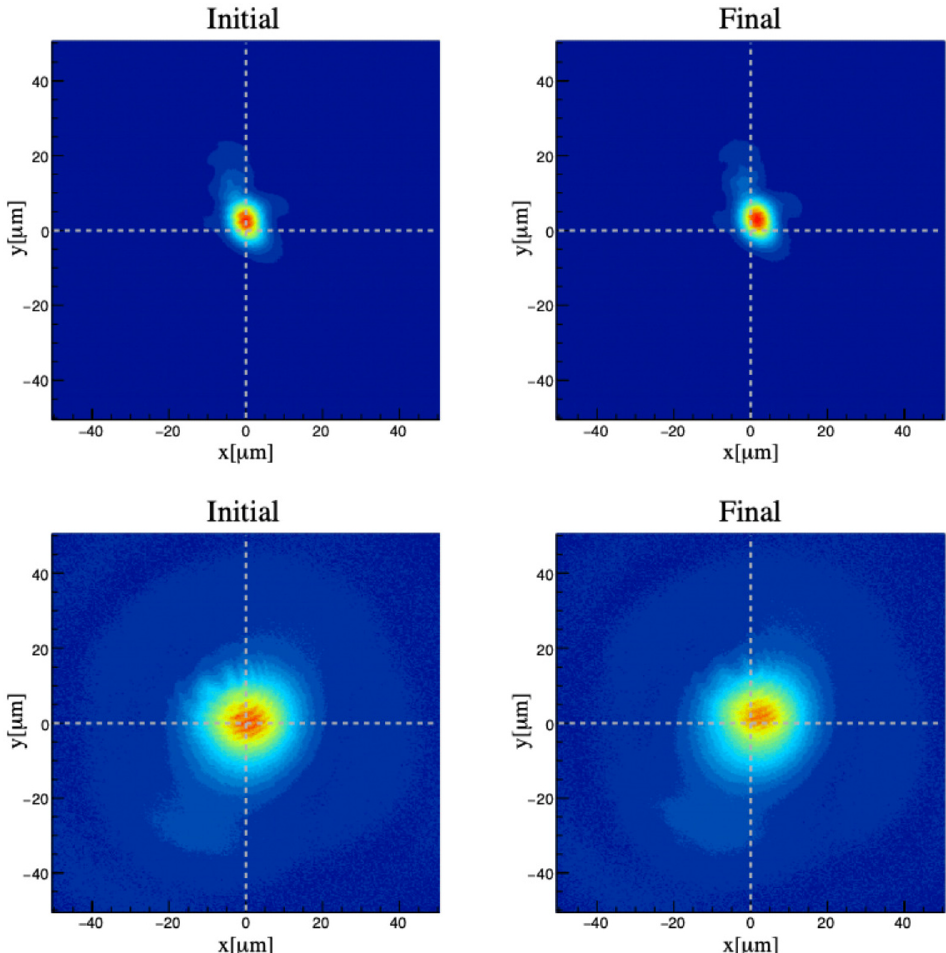
Figure 9 . Beam profiles of creation (upper) and inducing (lower) lasers at interaction point as captured by a common CCD camera. The left and right figures correspond to typical images taken at the beginning and end of a unit run period, where slight deviations in the focal spots are